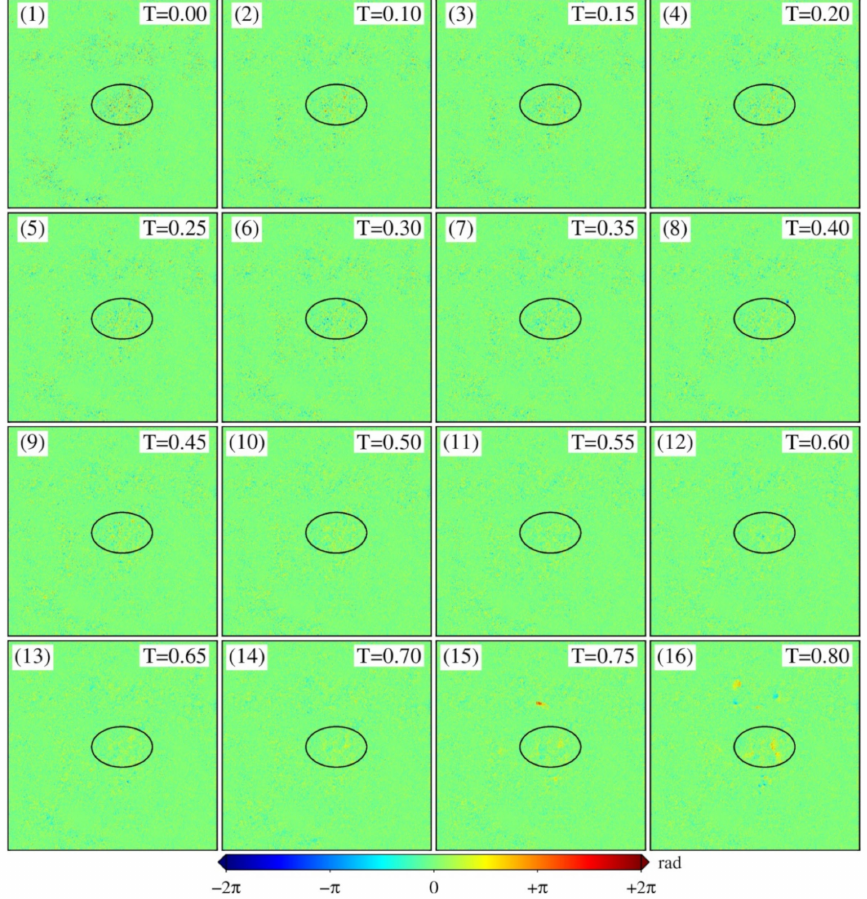
Figure 12. Unwrapping error with different coherence thresholds: ( 1 ), the error without hierarchical networking; ( 2 )–( 16 ) denote the unwrapping error of the new method under different thresholds; T, the coherence